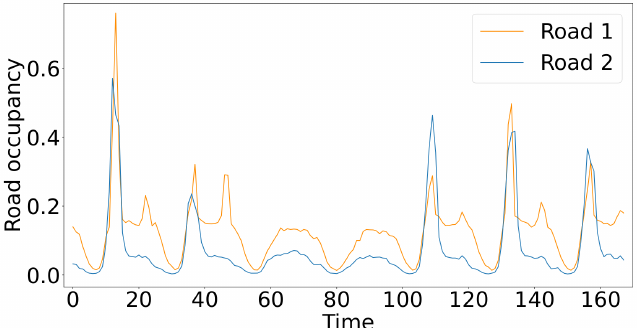
Figure 5. Road occupancy rate per